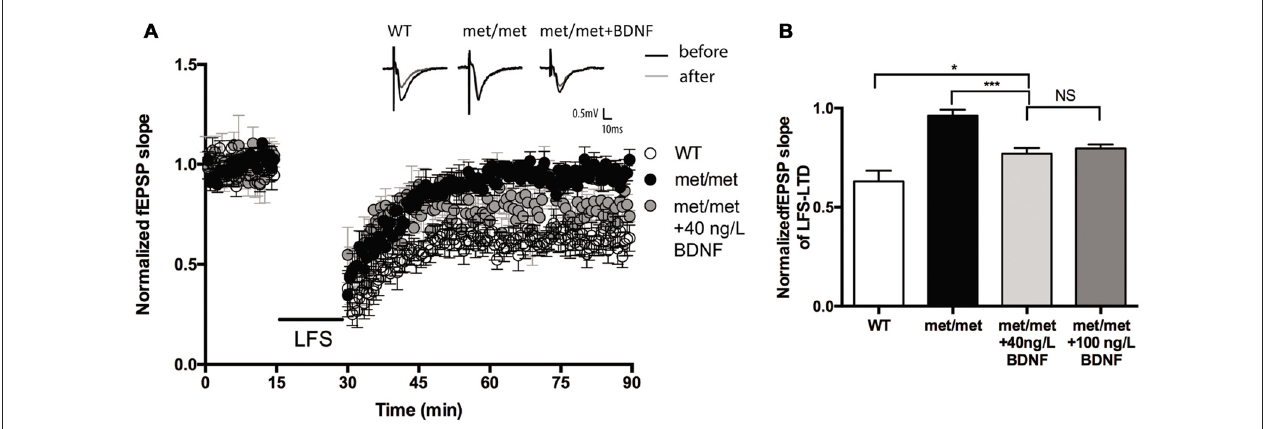
FIGURE 4 | BDNF partially rescued LFS-LTD in BDNF Met / Met mice. (A) LFS induced hippocampal LTD. Insert in (A) : typical fEPSP recordings were shown before LFS (black) or 60 min after LTD induction (gray). (B) Summary of the data showed the magnitude of LTD. (WT: N = 7 from four mice; BDNF Met / Met : N = 6 from four mice; BDNF Met / Met +BDNF: 40 ng/ml, N = 7 from four mice; 100 ng/ml, N = 6 from four mice). ∗ P < 0.05, ∗∗∗ P < 0.001.